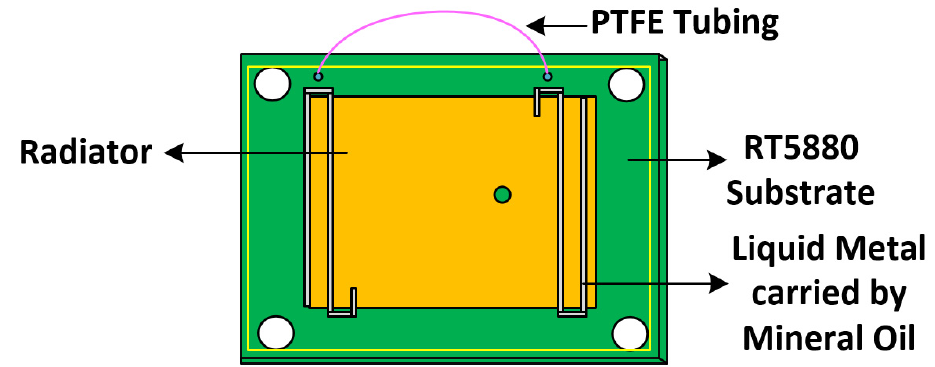
Figure 17. The picture of the microfluidic structure.